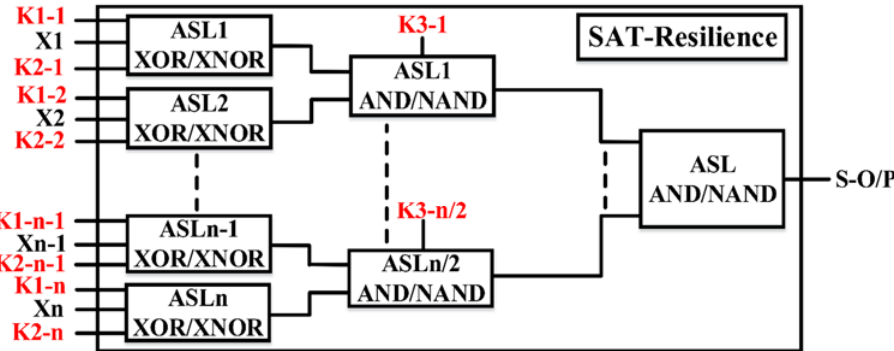
Figure 41. In Figure 41, X is the distinguished input ‐ bits, and K1, K2, and K3 are the external input keys. The final output of SAT ‐ resilience can be either “0” or “1” (based on the designer’s configuration) on applying the correct key, and the last inserted key ‐ gate (between the original output of the encrypted circuit and SAT ‐ resilient output (S ‐ O/P)) must be either XOR or XNOR, respectively, in order to obtain the correct output.